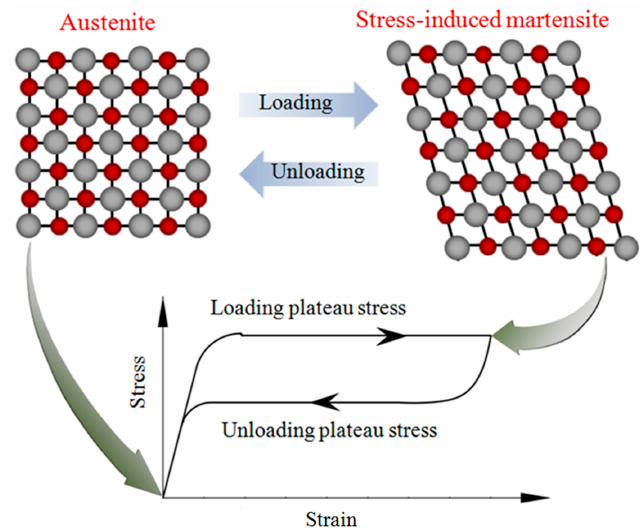
Figure 8. Schematic diagram of crystal structure evolution of NiTi SMA tube subjected to stress-induced martensite (SIM) transformation.